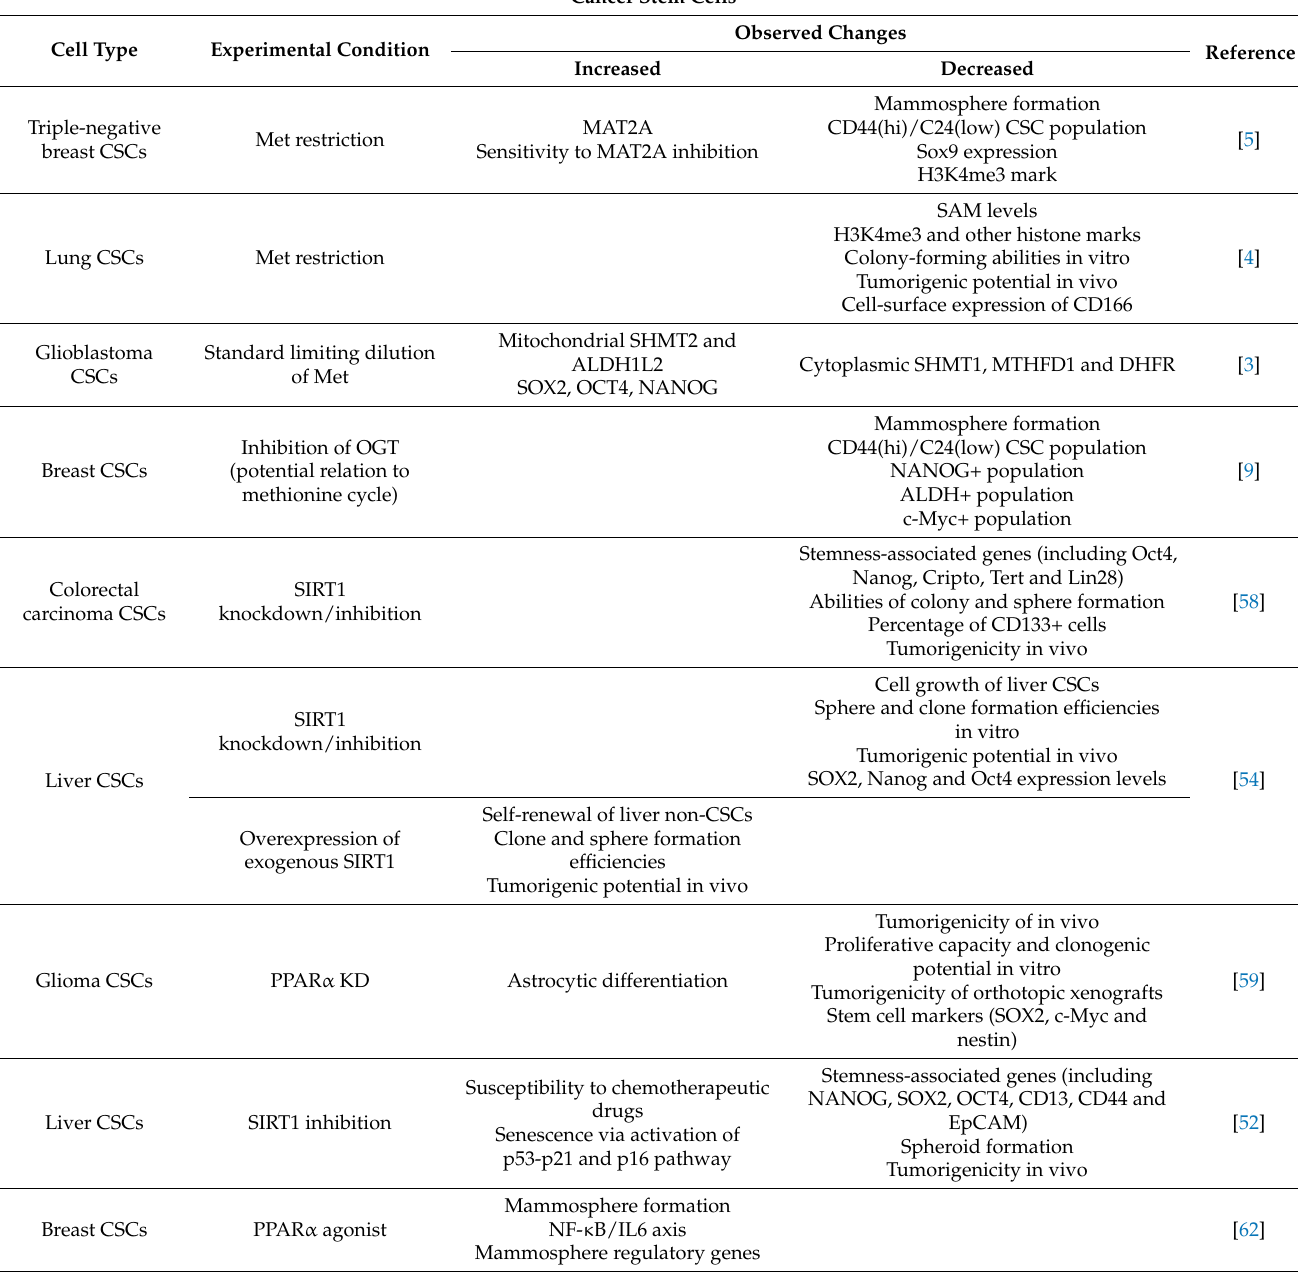
Table 2. Highlights of recent publications in relation to methionine restriction outcome and SIRT1/PGC-1 α /PPAR- α players in the stemness of cancer stem